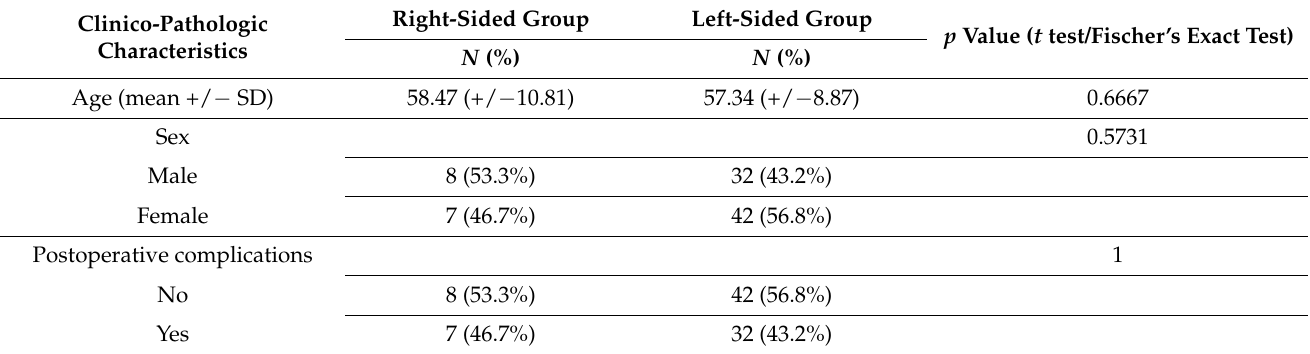
Table 1. Comparative characteristics of RAS-wt patients, according to the primary tumor